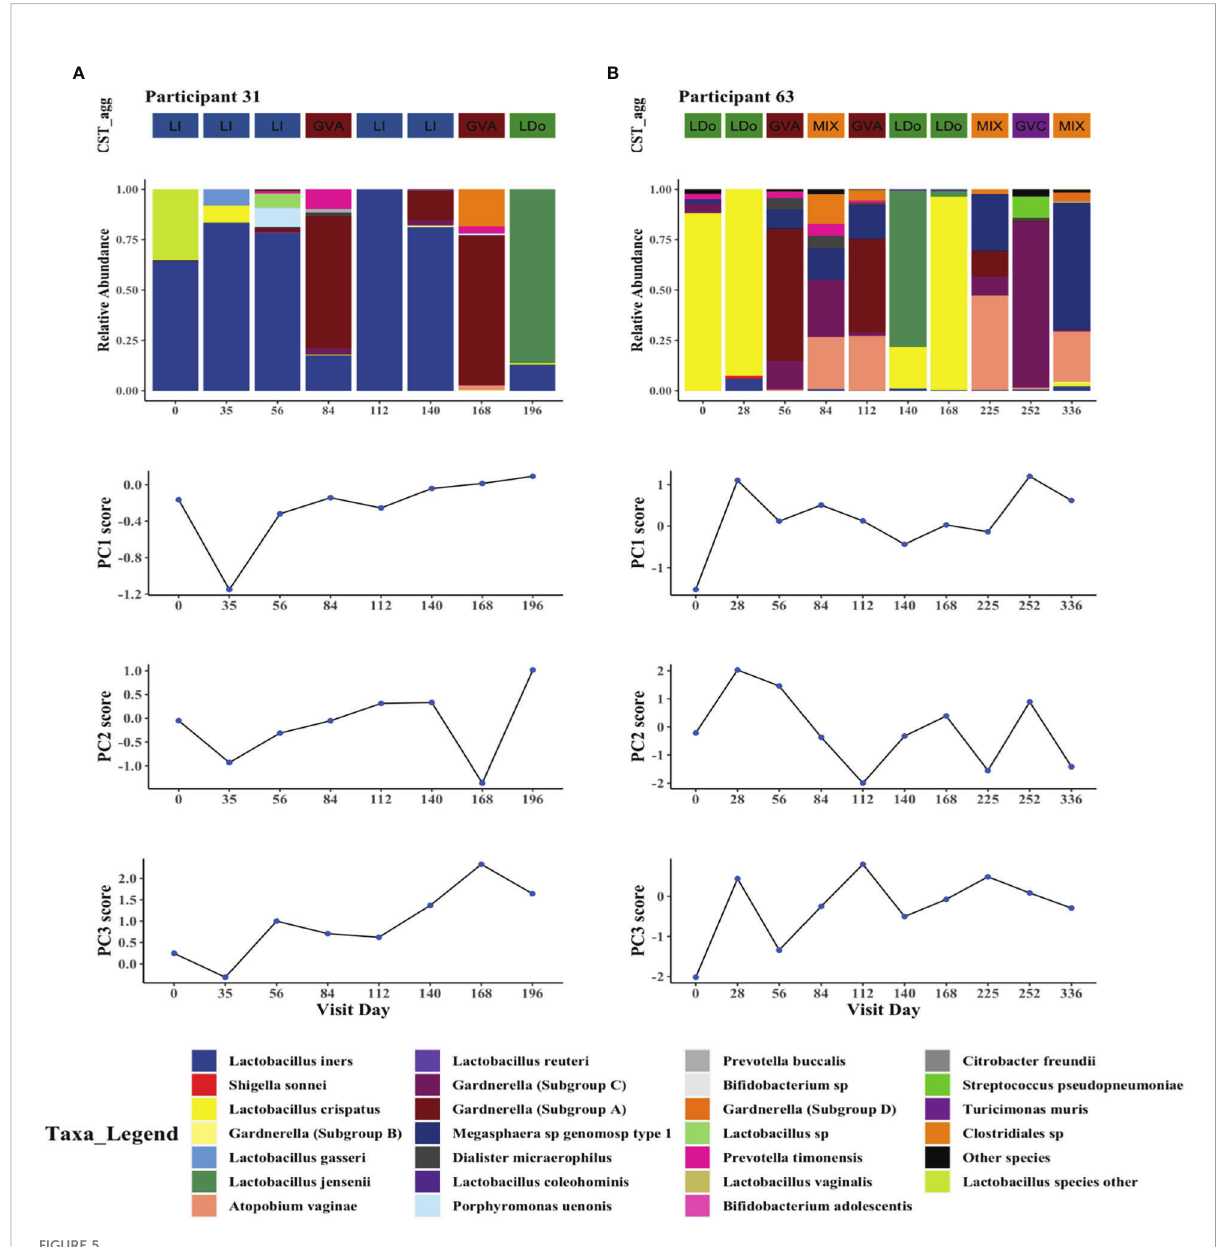
FIGURE 5 Intraindividual temporal microbiome changes correlate with changes in cervicovaginal cytokines in two study participants. Longitudinal changes in cervicovaginal microbiome pro fi les and concomitant changes in cytokine principal components PC1, PC2, and PC3 in (A) Participant 31, and (B) Participant 63. The 25 most prevalent microbial taxa are shown with the rest of the species grouped as “ other_species ” and “ Lactobacillus_other_species ”